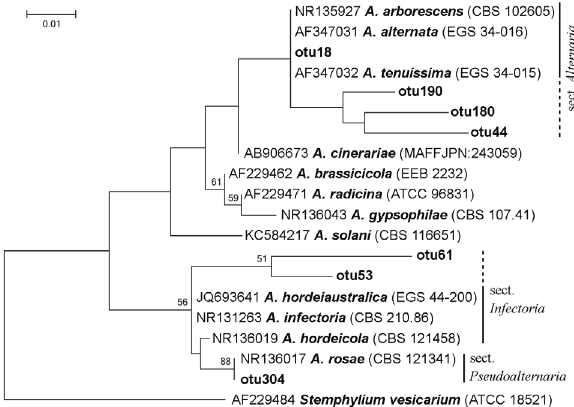
Figure 3 Maximum likelihood tree of OTUs related to the Alternaria genus. Bootstrap values based on 1000 replicates. Bootstrap values less than 50% are not